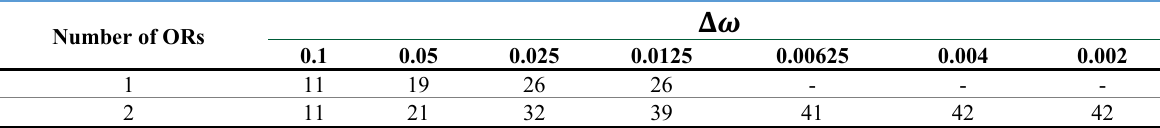
Table 6. Number of optimal positions according to the weight discretization (ORs-BTs) Number of ORs-BTs 0.1 0.05